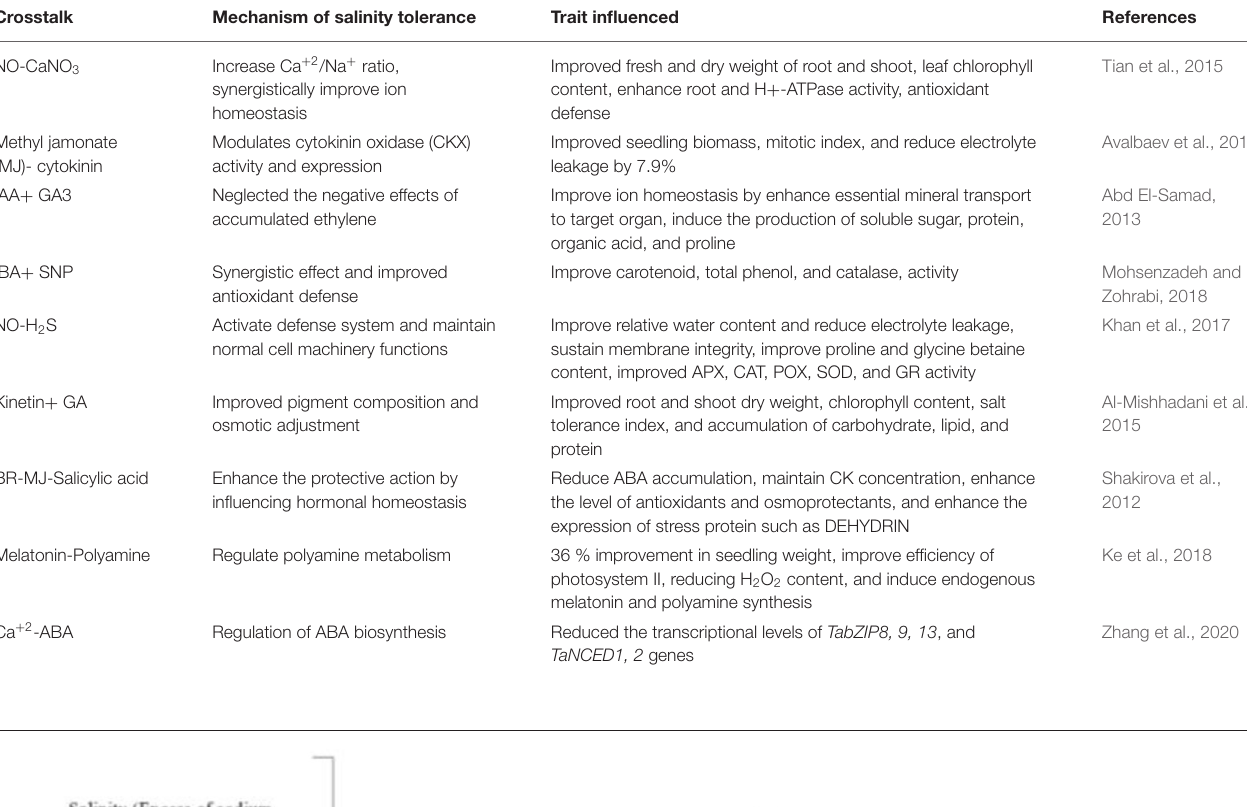
TABLE 2 | Highlights the crosstalk between plant growth regulators and signaling compounds to ameliorate the salinity stress in wheat crop. Crosstalk